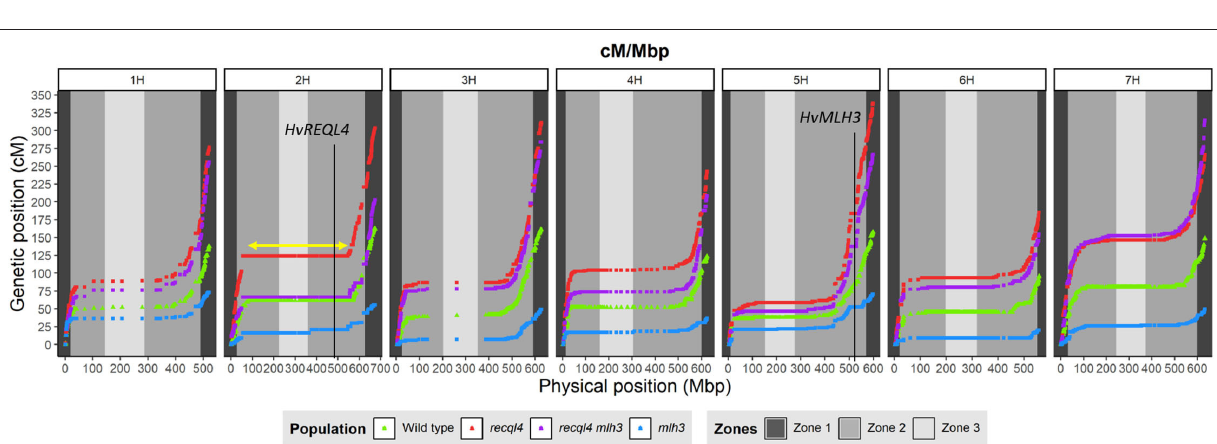
FIGURE 4 | Comparison of the genetic map (cM) and the physical map (Mbp) for each population (WT in green, mlh3 in blue, recql4 in red, and the double mutants in purple). The physical positions of HvRECQL4 and HvMLH3 are marked with a vertical line in 2H and 5H chromosomes, respectively. The yellow arrow marked in the 2H chromosome indicates the block introgressed together with HvRECQL4